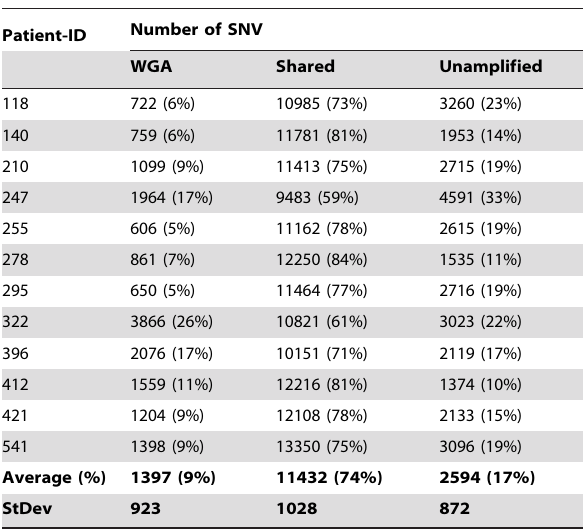
Table 3. Summary data for SNVs in positions identified in both WGA and unamplified sequence data, and using only one of the two